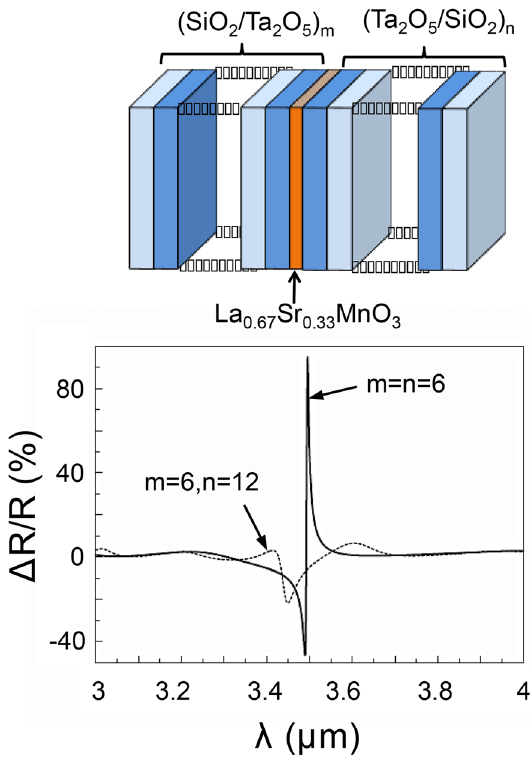
Figure 13: MRE modulation in CMR optical platforms. Spectra of the magnetic modulation of the reflectivity in a 1D Magneto Photonic Crystal for two different photonic structures. The dotted curve corresponds to a configuration with Bragg mirrors of different thicknesses(m=6,n=12)andthesolidcurvetoacon fi gurationwith symmetric Bragg mirrors (m = n = 6). The active material is a CMR magnesium oxide (La 0.67 Sr 0.63 MnO 3 ). Reprinted by permission